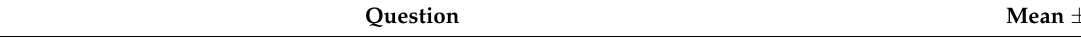
Table 5. Usability survey